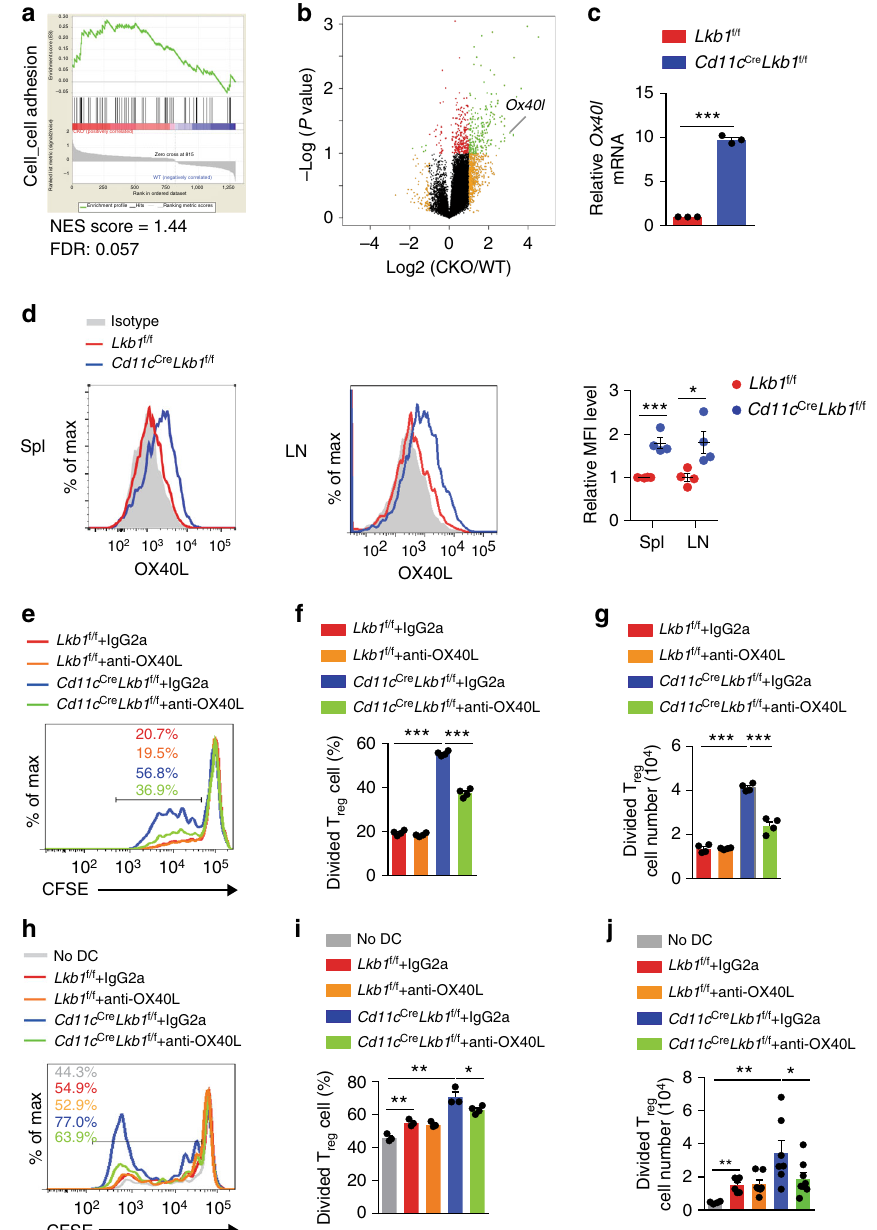
Fig. 4 Lkb1-de fi cient DCs promote T reg cell expansion through the OX40L-OX40 axis. a Gene set enrichment analysis (GSEA) of transcriptional pro fi les in WT and Lkb1-de fi cient DCs. The gene set of cell-cell adhesion was enriched in Cd11c Cre Lkb1 f/f DCs. FDR, false-discovery rate; NES, normalized enrichment score. b Volcano plot analysis of gene expression in splenic DCs from Lkb1 f/f and Cd11c Cre Lkb1 f/f mice. The points indicate the Log 2 fold change ( x axis) versus the – Log 10 P value ( y axis, representing the probability that the gene is differentially expressed). Black dots mark genes with P > 0.1 and less than two-fold change, and tinted dots mark genes with fold changes higher than 2. Ox40l is marked. c mRNA level of Ox40l in Lkb1 f/f and Cd11c Cre Lkb1 f/f DCs determined by real-time PCR. d Flow cytometric analysis and quanti fi cation of the relative mean fl uorescence intensity (MFI) of OX40L expression on DCs from the spleen and LNs of Lkb1 f/f and Cd11c Cre Lkb1 f/f mice. e – g Flow cytometric analysis ( e ), percentage ( f ), and absolute number ( g ) of CFSE-labelled T reg cells (CD4 + Foxp3 + , 2×10 5 ) sorted from B6 mice after 4 days of co-culture with DCs (1×10 5 ) sorted from Lkb1 f/f and Cd11c Cre Lkb1 f/f mice pre-blocked with OX40L neutralizing antibodies or isotype control. h – j Flow cytometric analysis ( h ), percentage ( i ) and number ( j ) of CFSE-labelled T reg cells (CD4 + Foxp3 + , 2×10 6 ) sorted from B6 mice transferred together with or without DCs (1×10 6 ) sorted from Lkb1 f/f or Cd11c Cre Lkb1 f/f mice pre-blocked with OX40L neutralizing antibodies or isotype control into irradiated NSG mice via tail vein injection for 3 days. The results are presented as the mean ± S.E.M., * P < 0.05, ** P < 0.01, *** P < 0.001, by Student's t -test ( c , d , f , g , i , j ). Data are pooled from c , d , f , g , i , j or are representative of at least three e , h independent experiments with similar